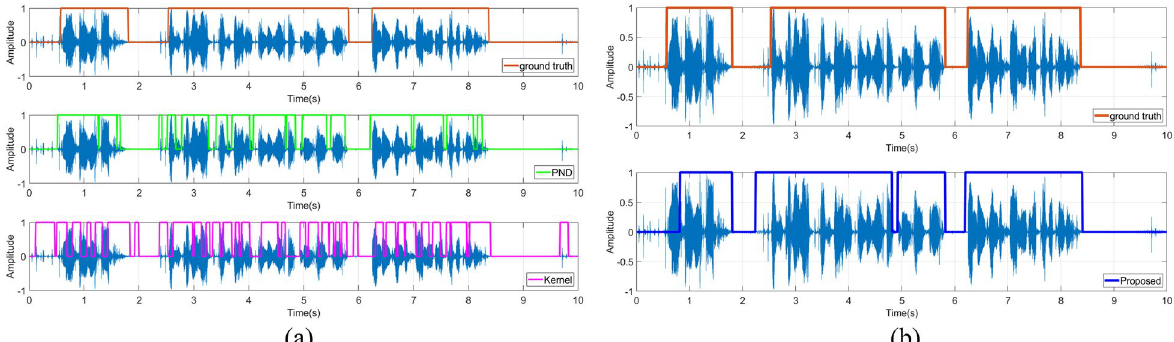
Fig. 9 The performance of the proposed detector, with a transient of door knocking. The light blue line is the input audio signal with transient, and the red line is the ground‑truth representing the frames containing speech. The green, magenta and dark blue line are, respectively, the detection result of “PND,” “Kernel,” and “Proposed”